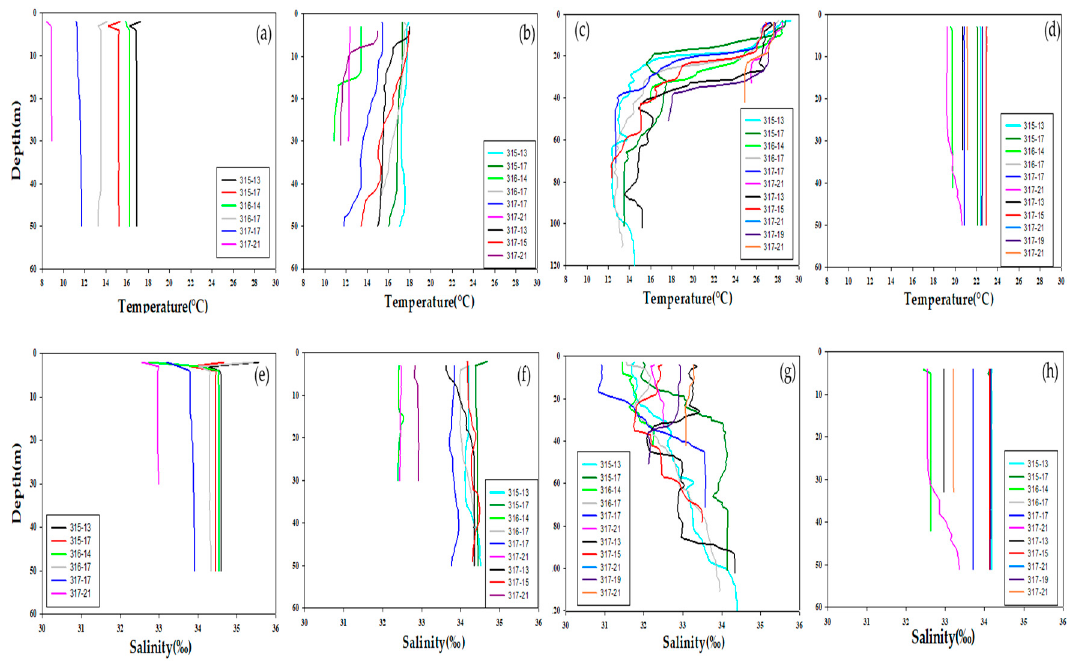
Figure 2. Vertical profiles of temperature and salinity in the northern East China Sea, 2018. ( a ) February, ( b ) May, ( c ) August, and ( d ) Nov for temperature; and ( e ) February, ( f ) May, ( g ) August, and ( h ) November for salinity.